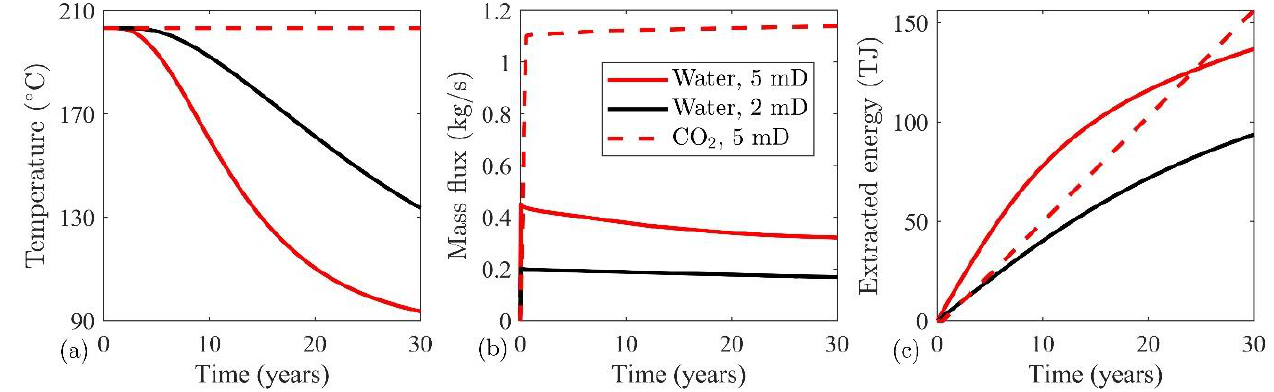
Figure 5. Comparison of working fluid effects, ( a ) temperature at the production well, ( b ) mass flux of different fluid, and ( c ) extracted energy.